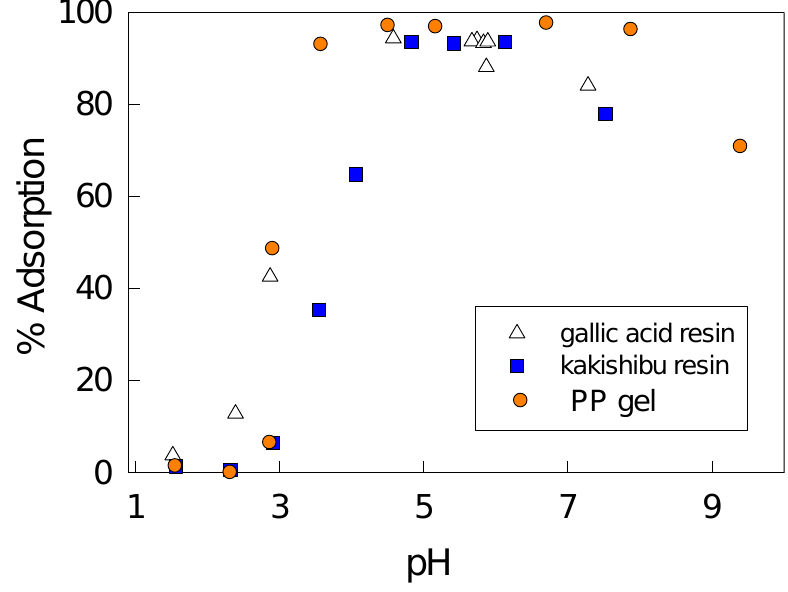
Figure 1. Percentage adsorption of uranium(VI) at varying equilibrium pH on PP gel, gallic acid resin and kakishibu